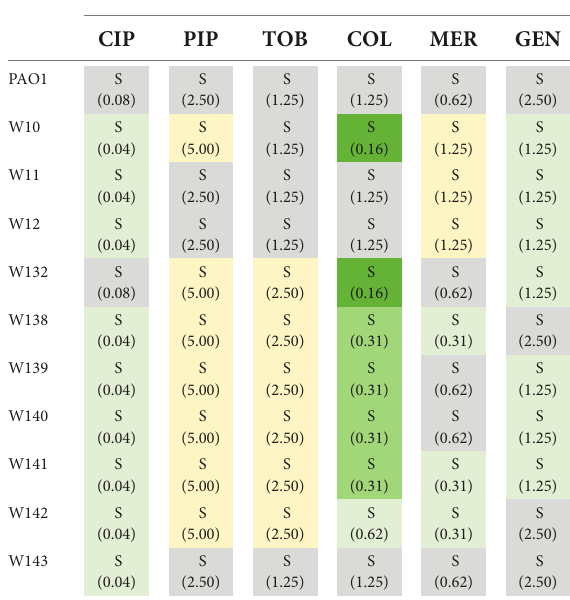
TABLE 3 Minimum inhibitory concentration (MIC) determination of six main antibiotics used for the treatment of P. aeruginosa